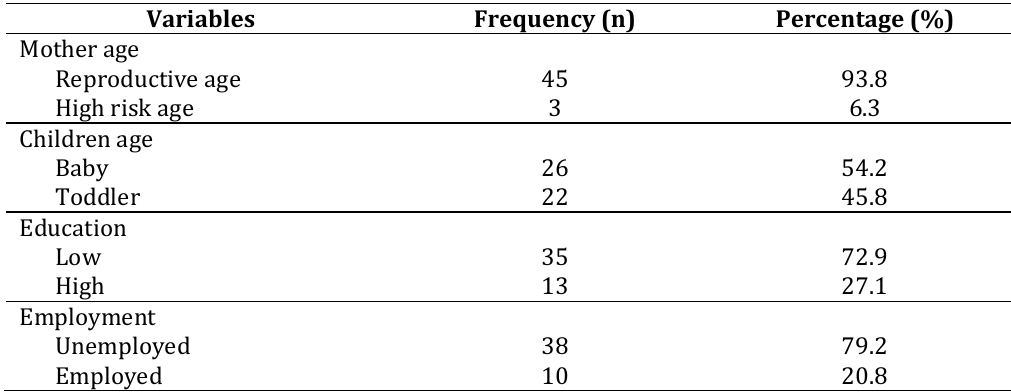
The frequency distribution on mother’s age, child’s age, education and